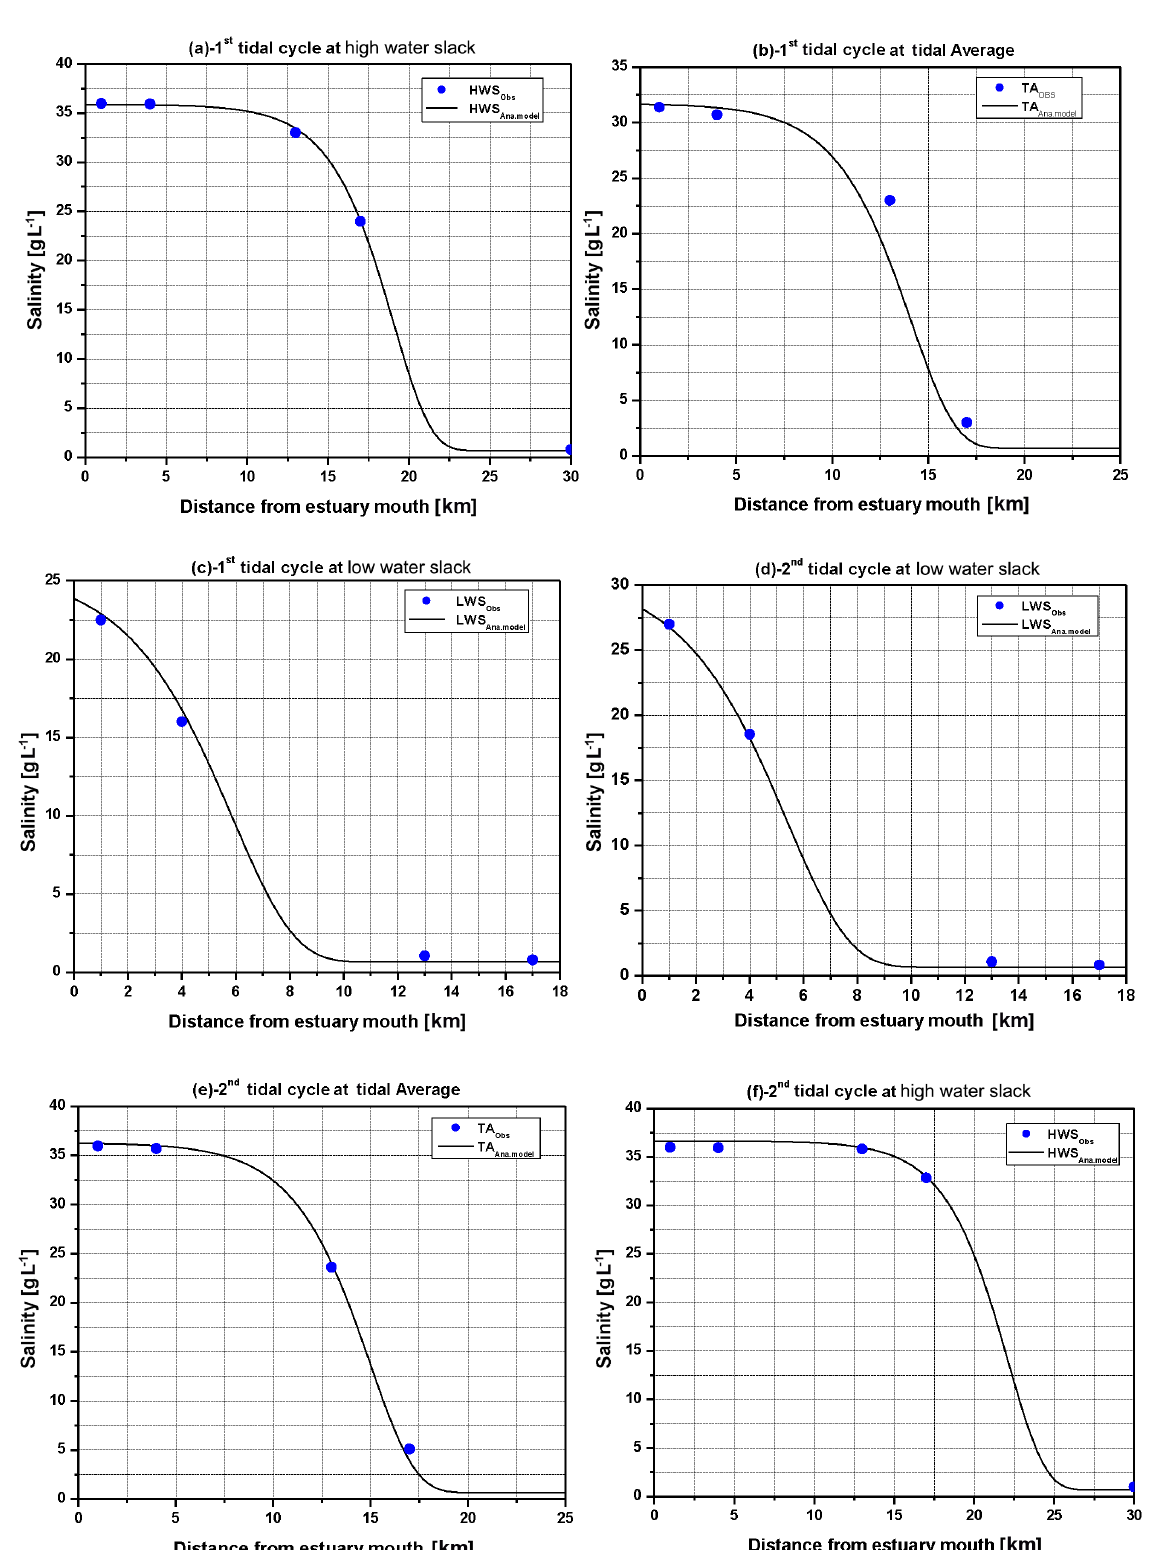
Figure 10. Observed and analytically computed longitudinal salinity distribution along the Sebou estuary (surveyed on 28 September 2015) during 1st cycle (a, b, c) at LWS, TA and HWS, and 2nd cycle (d, e, f) at LWS TA and